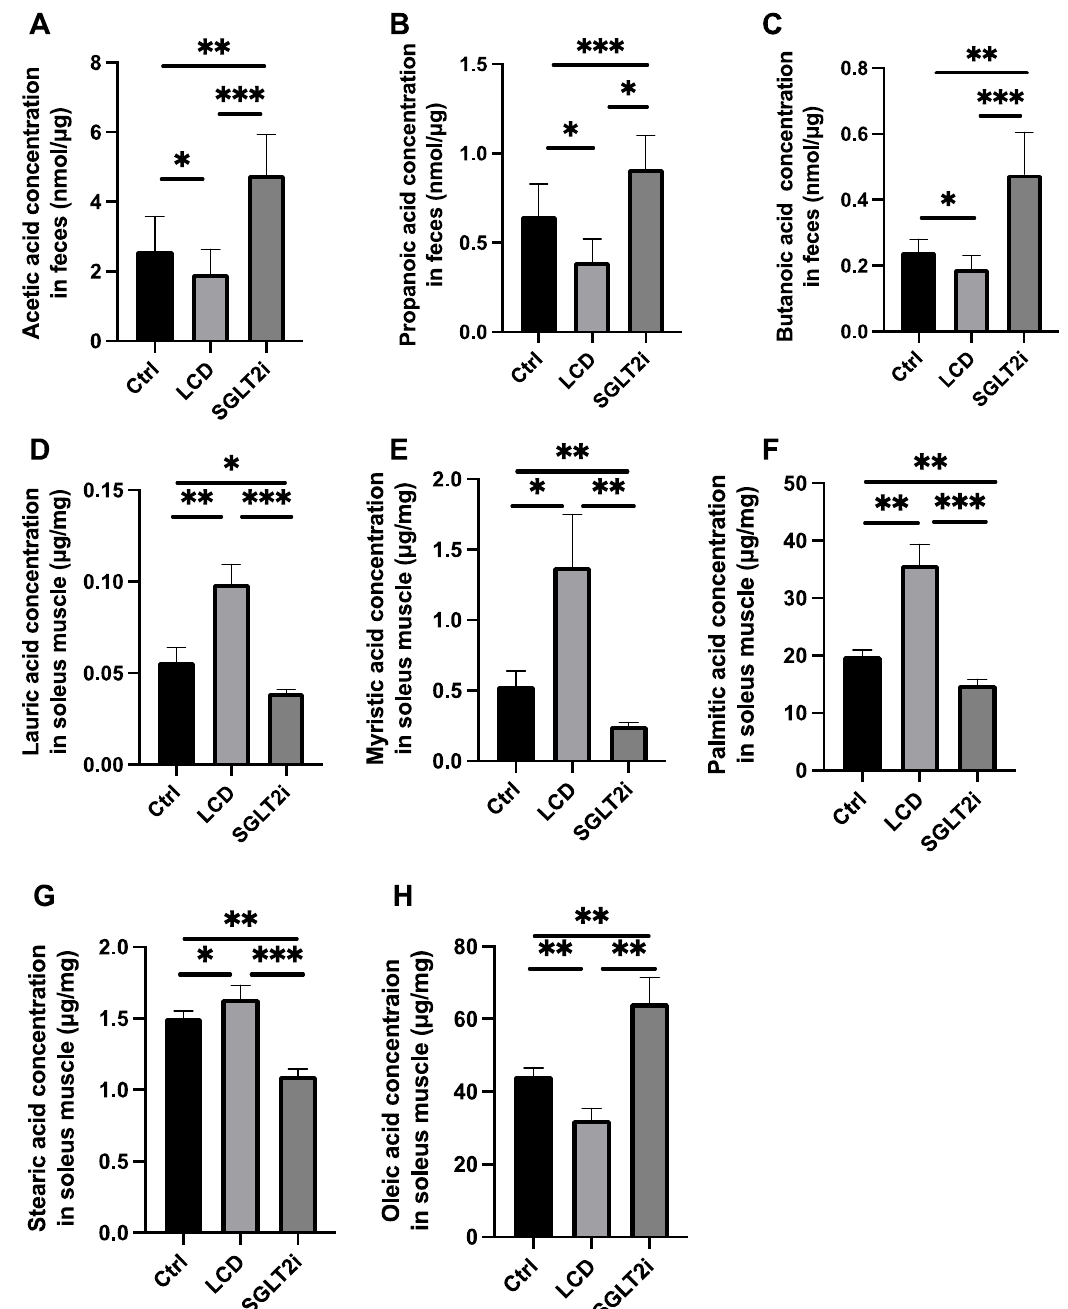
Figure 4. The fecal concentration of short-chain fatty acid and the concentration of saturated fatty acid and unsaturated fatty acids in the soleus muscle. The fecal concentration of ( A ) acetic acid, ( B ) propanoic acid, and ( C ) butanoic acid. The concentrations of ( D ) lauric acid, ( E ) myristic acid, ( F ) palmitic acid, ( G ) stearic acid, and ( H ) oleic acid in the soleus muscle. Data are mean ± SD. Statistical analyses were conducted using ANOVA. * p < 0.05, ** p < 0.01, and *** p < 0.001.